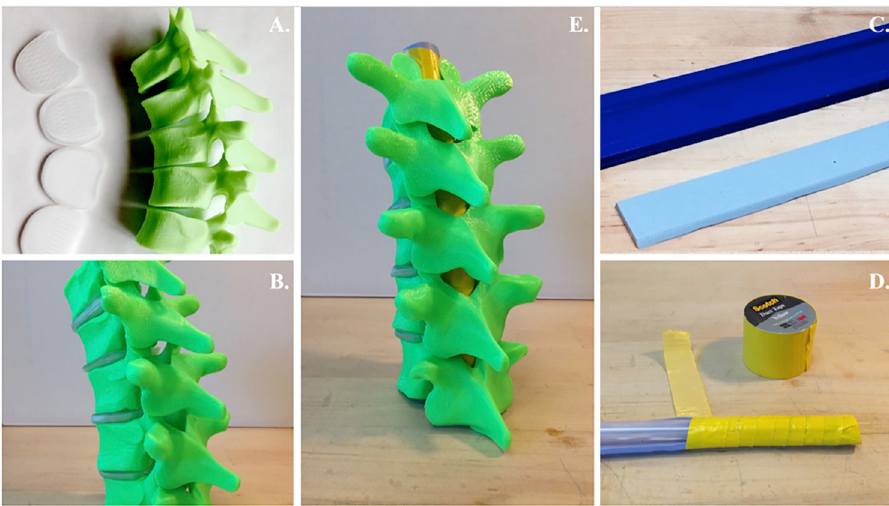
Fig 1. Steps in model fabrication. Fabrication of 3D-printed thoracic vertebrae and discs (A), vertebrae and discs epoxied together (B), ligamentum flavum and mold (C), ligamentum flavum secured to bubble tea straw with duct tape (D), ligament and bubble tea straw shown within vertebral canal